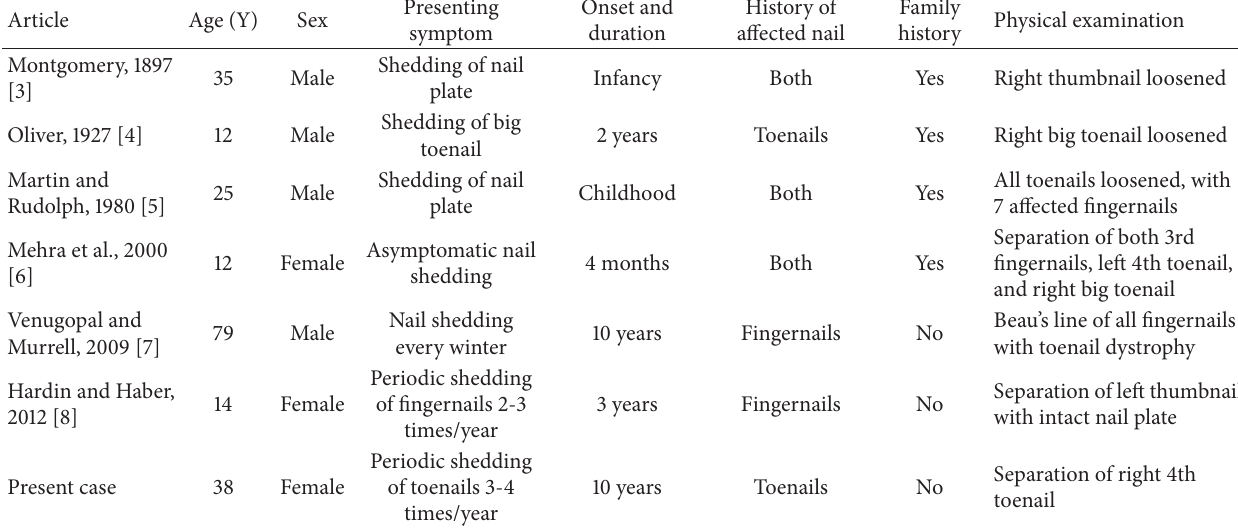
Table 1: Clinical characteristics of previously reported cases of idiopathic